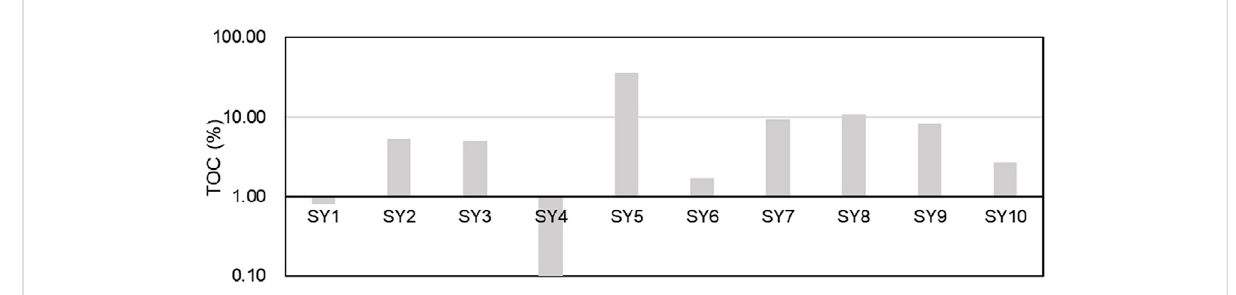
FIGURE 3 TOC content of shale